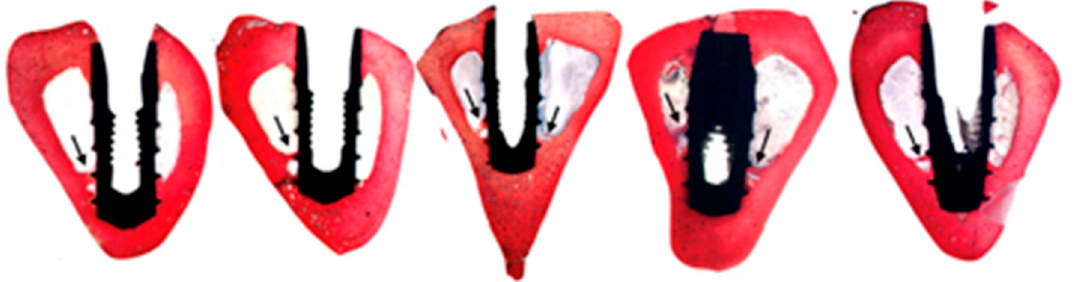
Figure 6. Histological sections of 5 implants in the test group (Group A) where the bone buttresses that grow from the cortex to the implant surface have been highlighted with a black arrow.